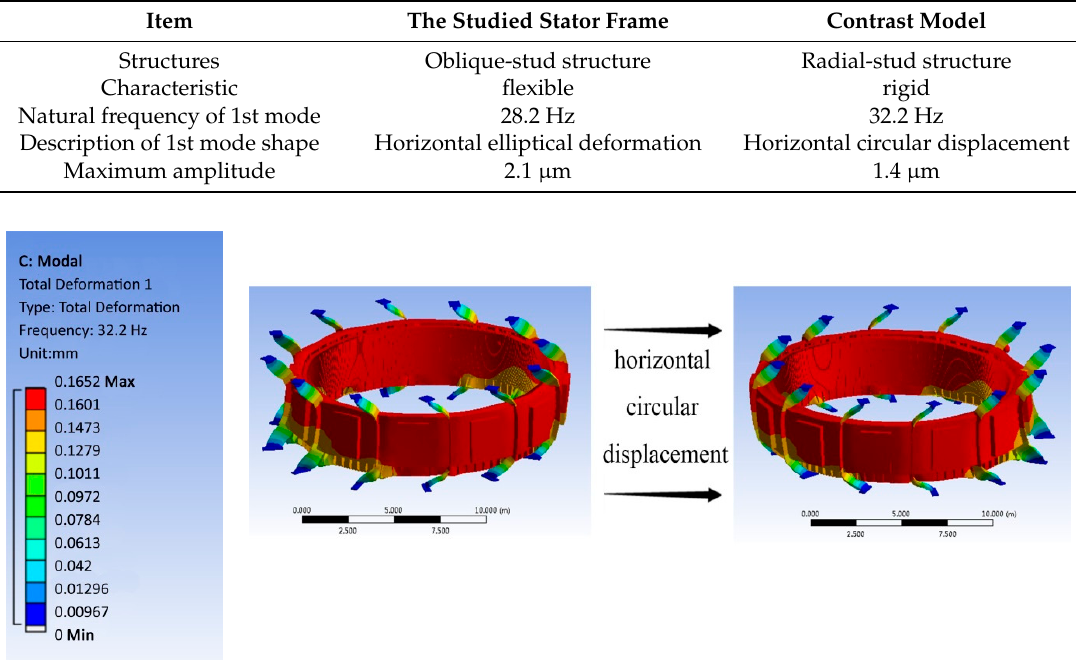
Figure 19. The first order mode-shape of the contrast model at 32.2 Hz.